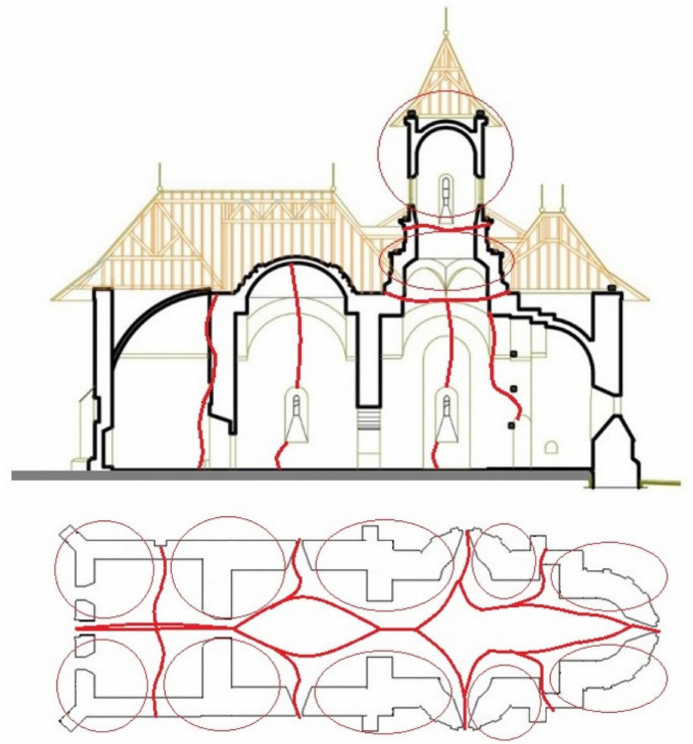
Figure 4. Crack pattern. Multiple transverse fractures (porch, narthex, nave, and Sanctuary) and longitudinal fractures of the